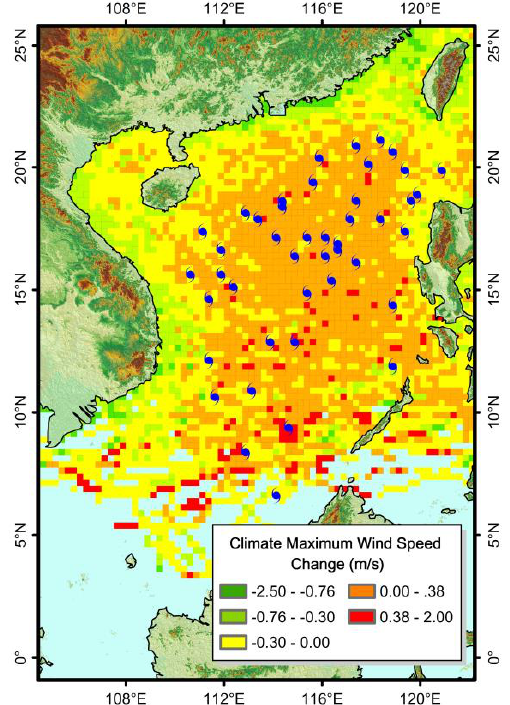
Figure 8. Cell-based average of the variations in maximum wind speed along TCs from 1949 to 2013. The blue dots show warm ocean eddies that encountered intensifying TCs in the South China Sea.